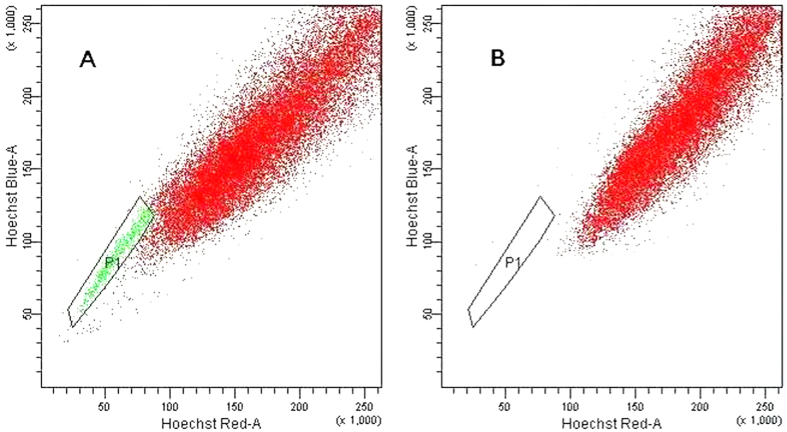
SP cells analysis.(A) SP cells were detected in HepG2 and 18 of the 21 fresh HCC tissue samples. The percentage of SP cells was 3.2% and 1.1–4.6%, respectively. Shown was one of the representative flow cytometry profiles, boxed green dots indicated the sorted SP cells. (B) SP cells (green dots) disappeared with verapamil (a calcium channel blocker) treatment. SP, Side Population.